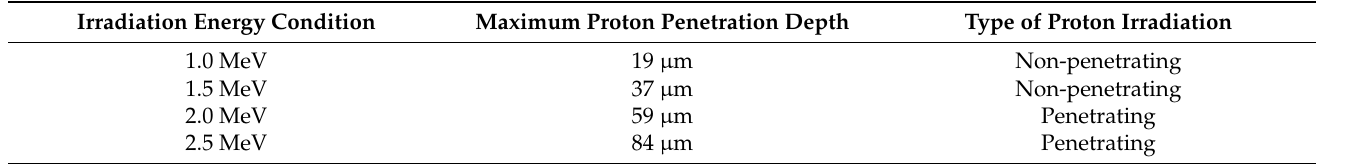
Figure 1. Chemical structure of PI. Table 1. The maximum proton penetration depths in the PI samples calculated using SRIM.